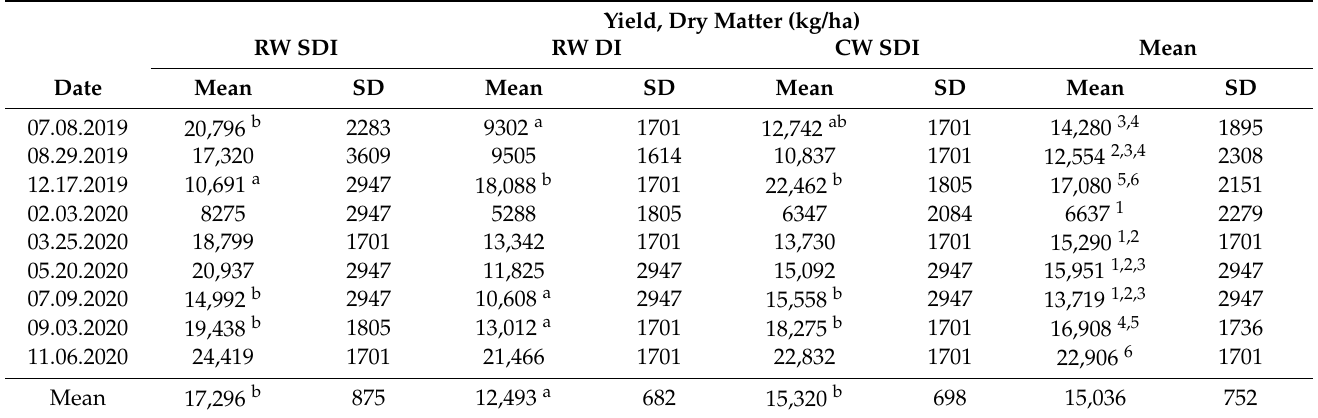
Table 7. Mean and SD of dry matter yield (kg DM · ha − 1 ) obtained per harvest and treatment. Yield, Dry Matter (kg/ha) RW SDI RW DI CW SDI Mean